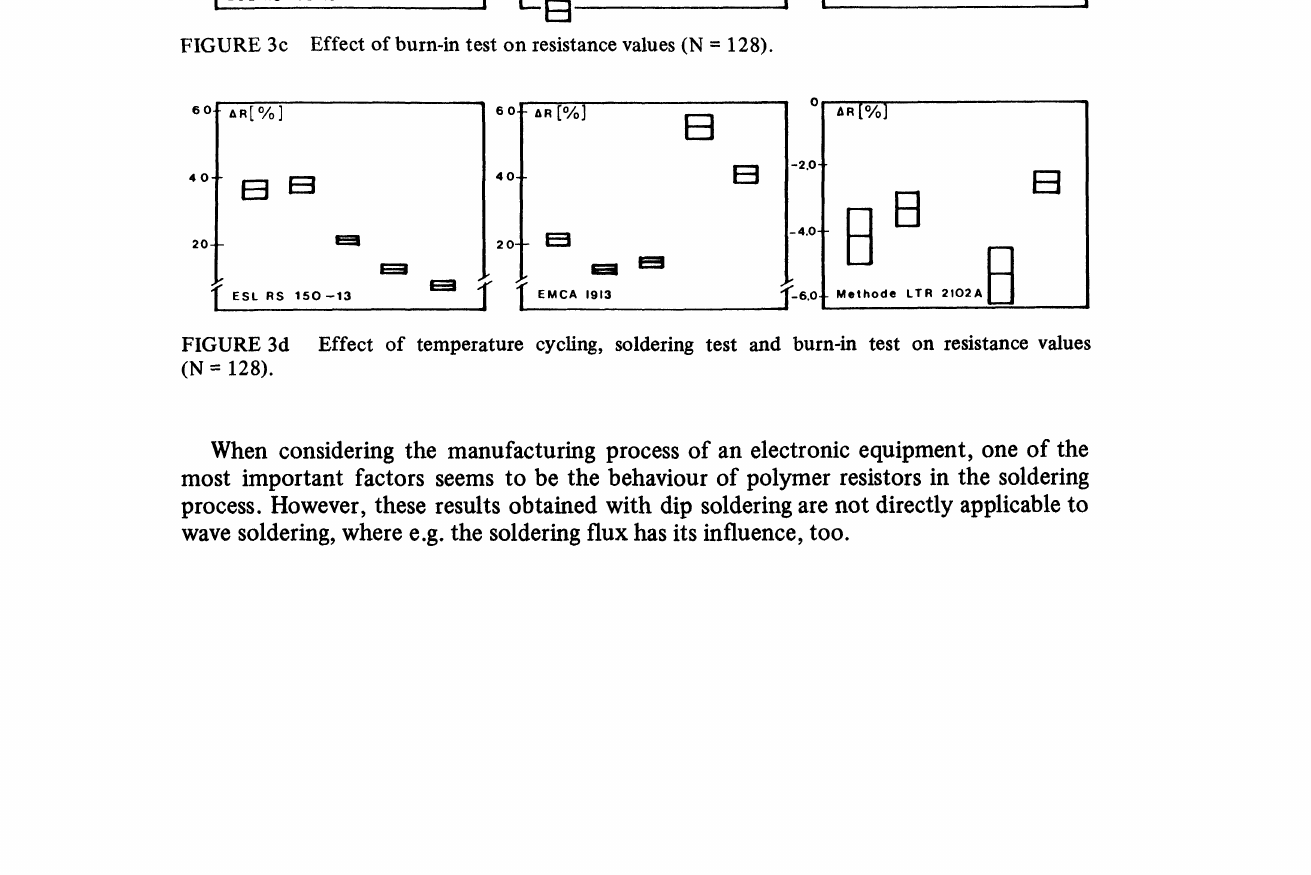
FIGURE 3c Effect of burn-in test on resistance values (N 128).